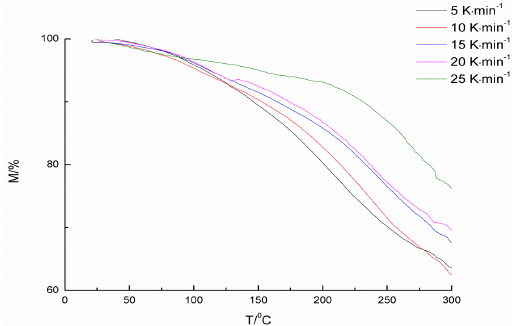
Figure 4. TGA curves of the blocked isocyanate at different heating rates.